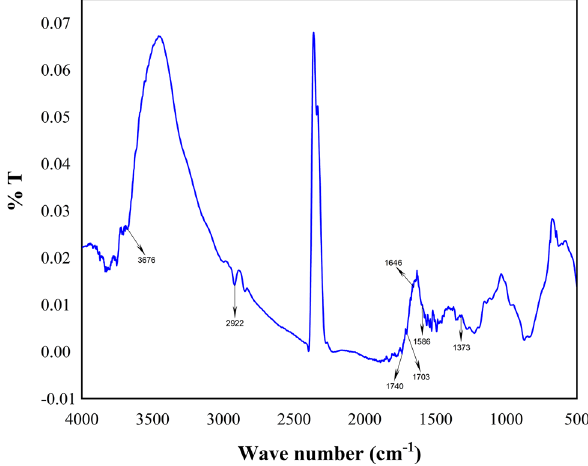
Fig. 9 FTIR analysis of the coagulant (MO–chitin) Fig. 10 XRD analysis of the coagulant